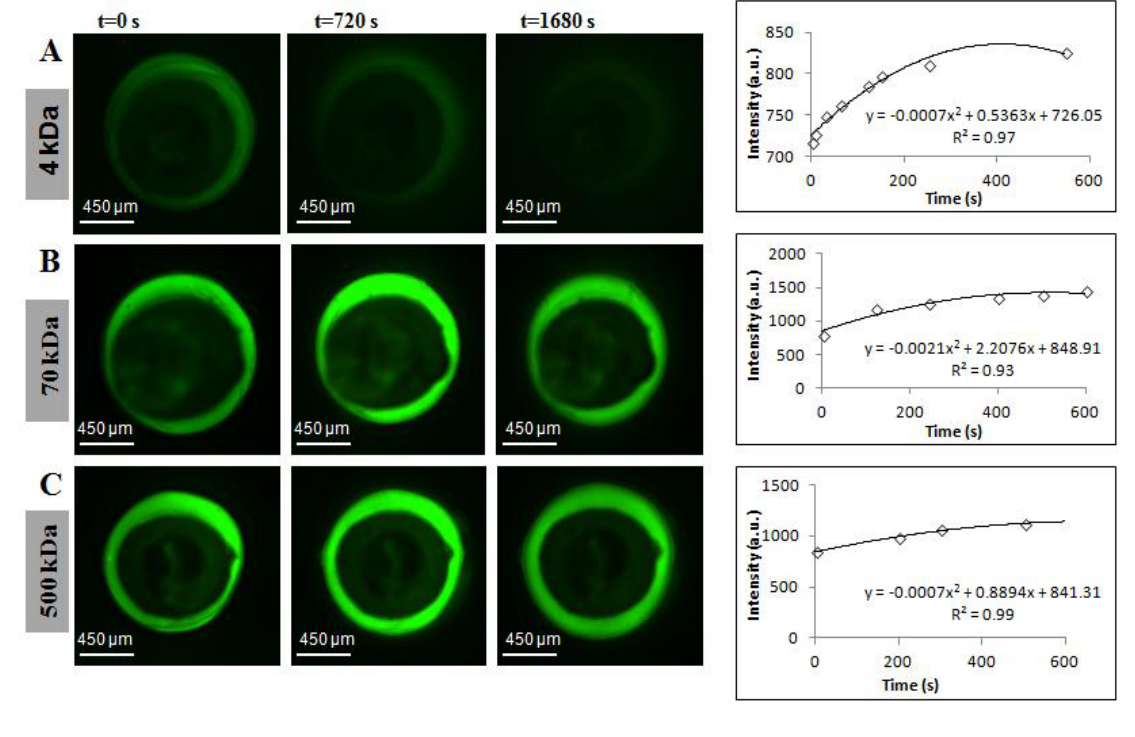
Figure 2. Fluorescence diffusion profiles of FITC-dextrans from hollow alginate microfibers and corresponding intensity changes in the bulk solution. Molecular weights used to perform empirical diffusion experiments were: ( A ) 4 kDa; ( B ) 70 kDa; and ( C ) 500